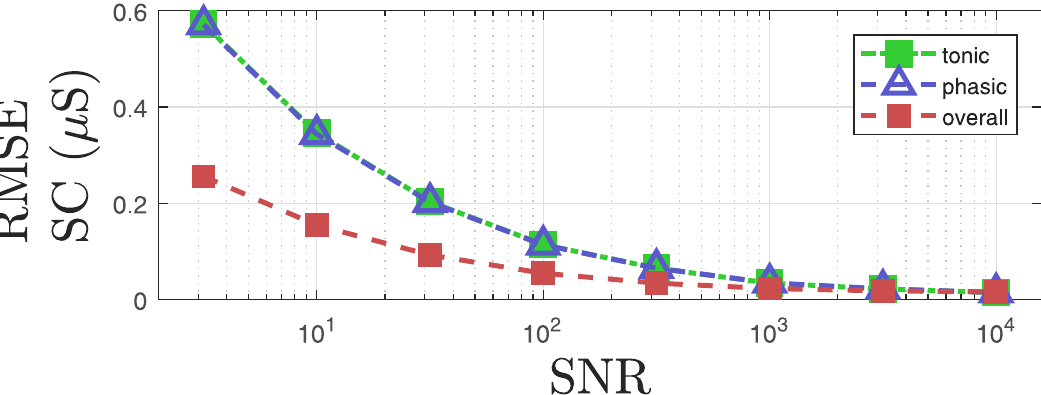
Fig 9. Root mean square error (RMSE) of the reconstruction for SC signal and corresponding components with respect to the ground truth. Green, blue and red dashed lines denote the RMSE for the reconstructed tonic component, phasic component and overall SC data in different noise levels. The data is simulated using the obtained results from the all experimental data in [31]. As noise is added to the phasic component prior to addition of tonic component, the SNR is given with respect to the phasic